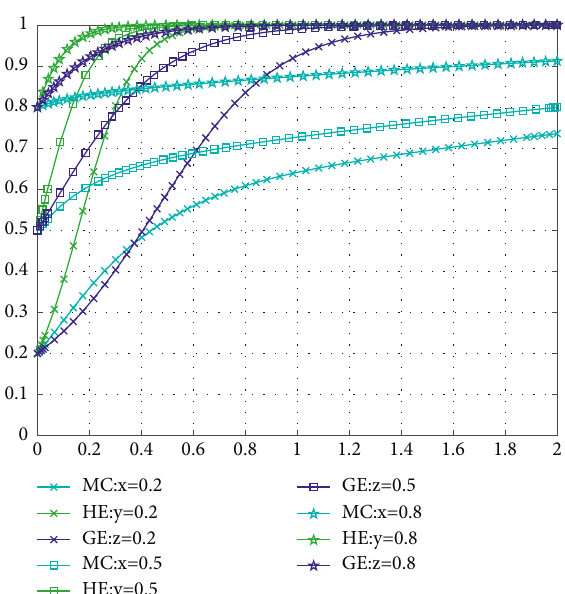
Figure 1: The evolution of the tripartite game under the initial